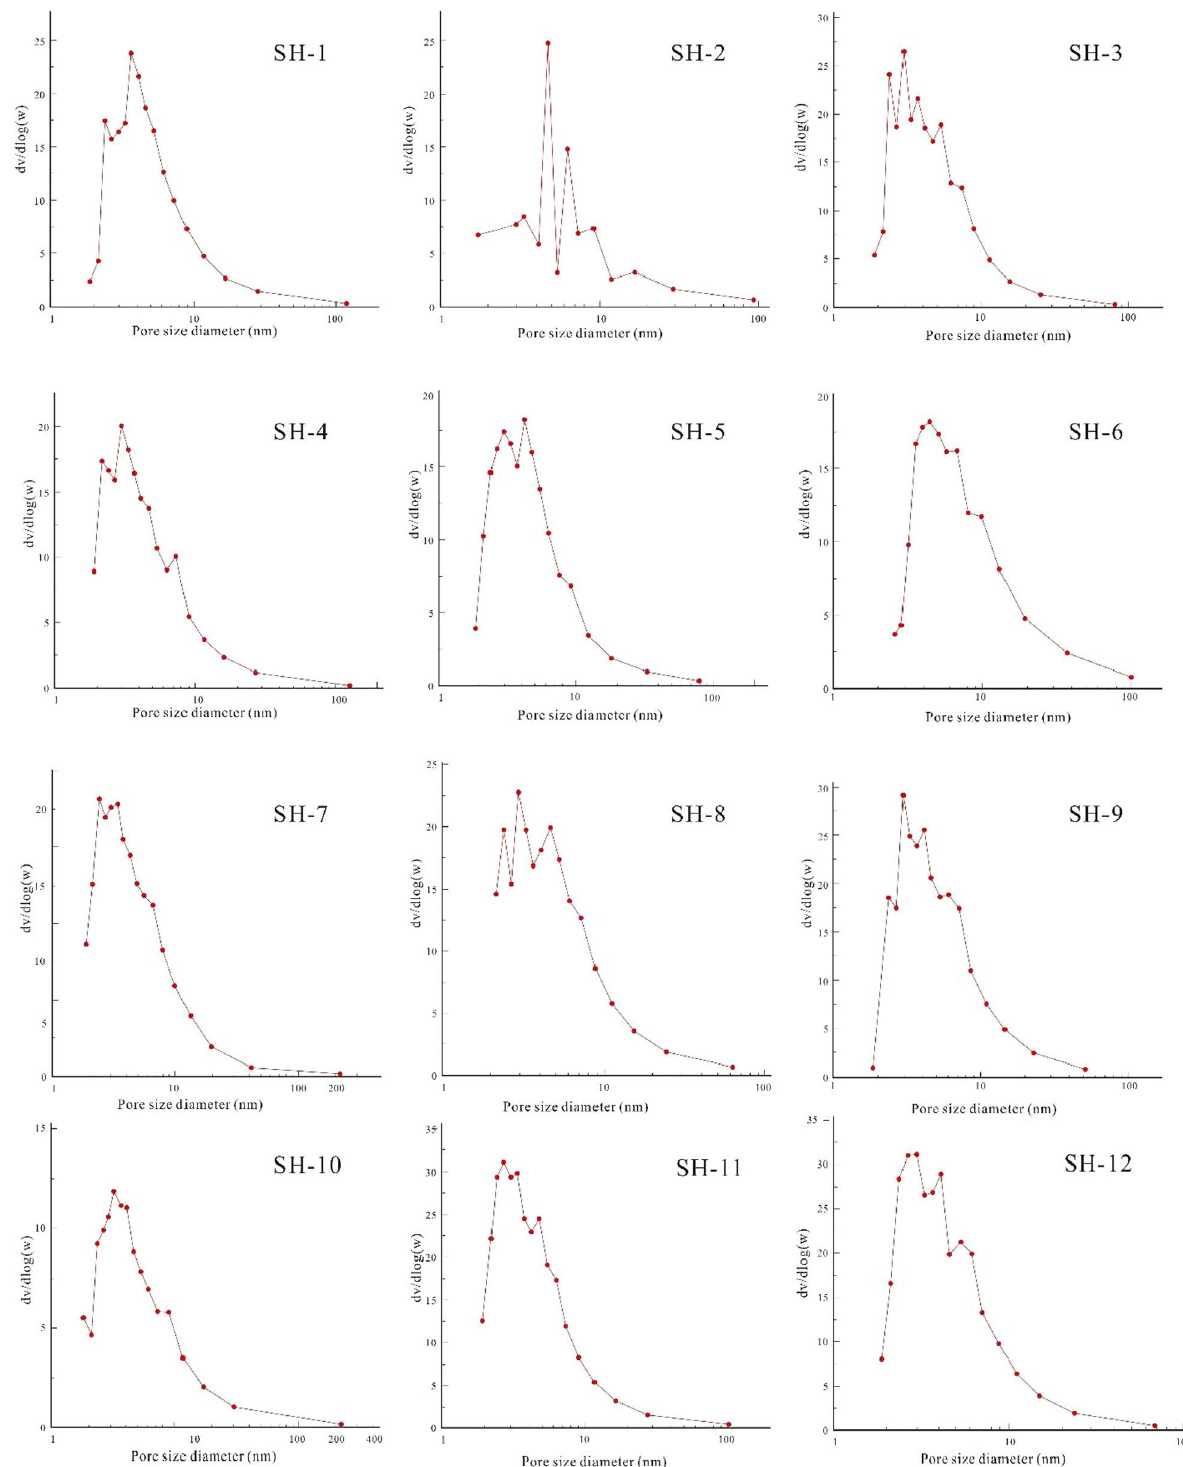
Fig. 8 Pore volume–pore size differential distribution in coal